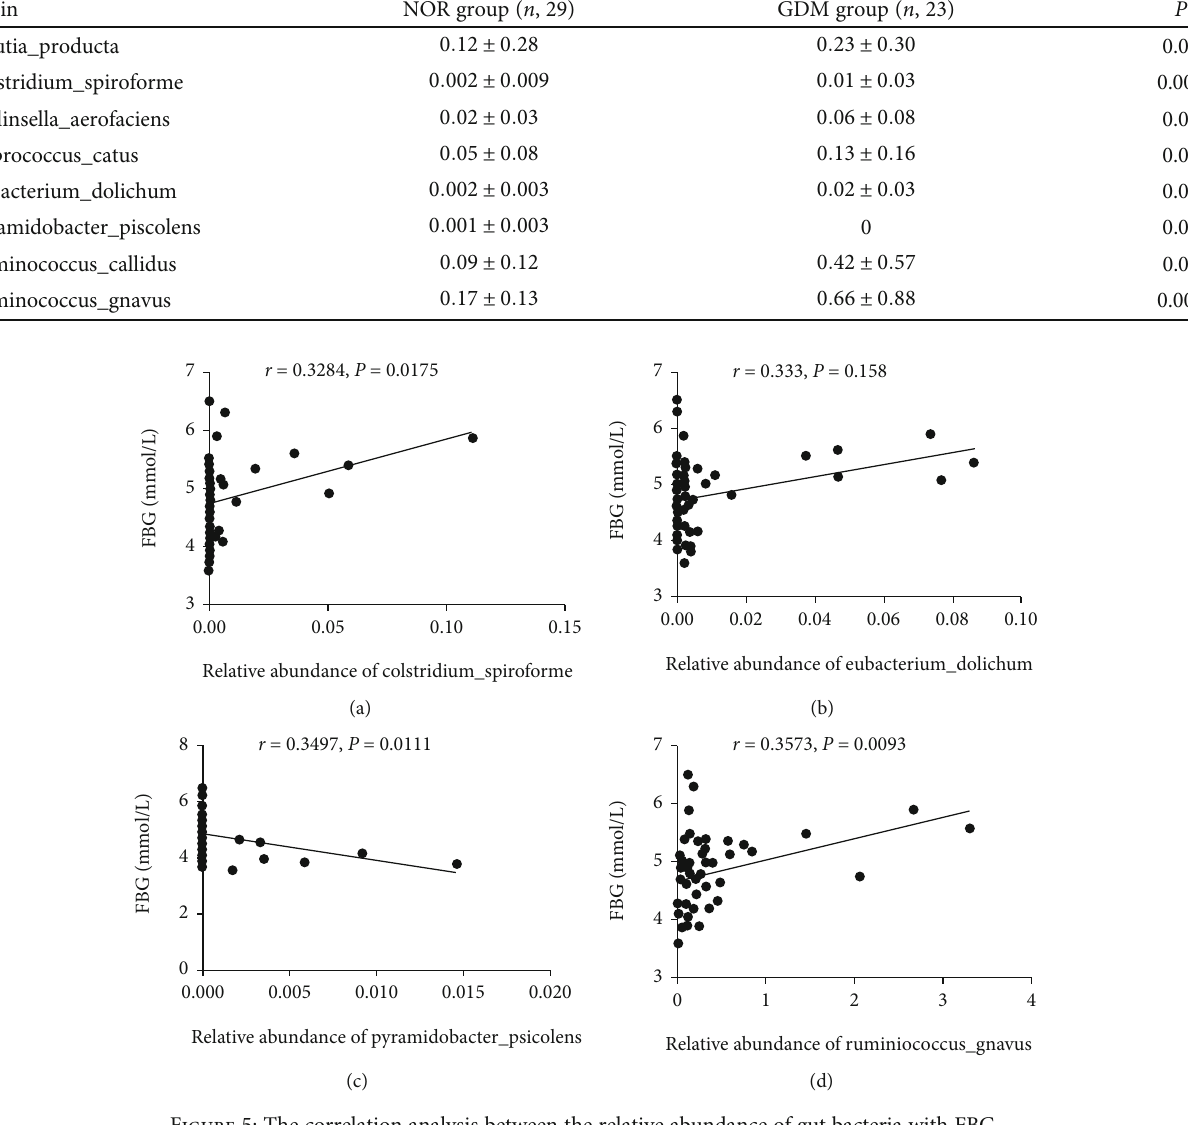
Figure 5: The correlation analysis between the relative abundance of gut bacteria with